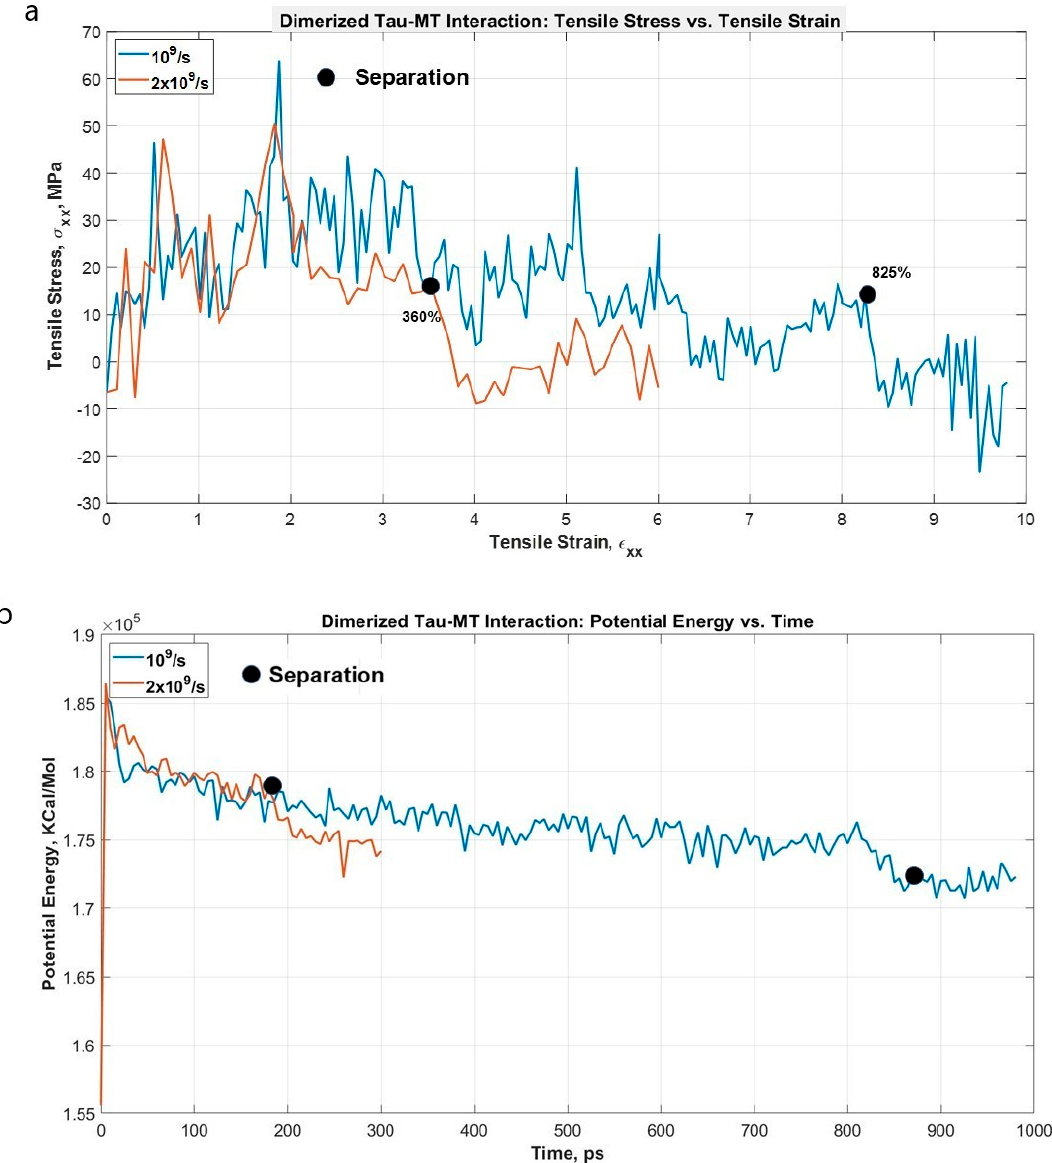
Figure 7. ( a ) Stress vs. Strain graph for the projection domain of tau during the pulling at different strain rates. The separation occurs early for higher strain rate (~360%), and much later for lower strain rate (~825%). ( b ) Potential energy vs. time plot for the dimerized tau-MT system. As expected, potential energy drastically reduces at separation (~360% strain for 2 × 10 9 s − 1 , ~825% strain for 1 × 10 9 s − 1 ). For both cases, the tau-tau bond is stronger than the tau-MT bond.